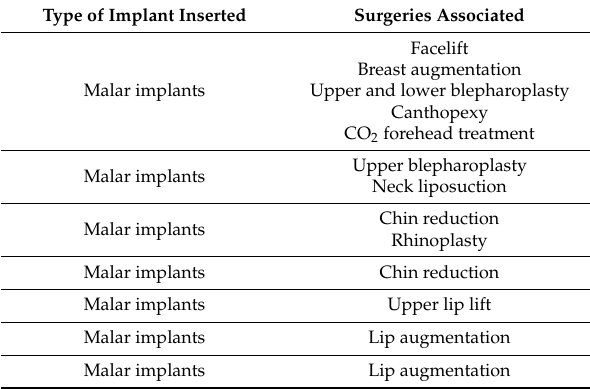
Table 1. All surgeries associated with facial implant insertions are